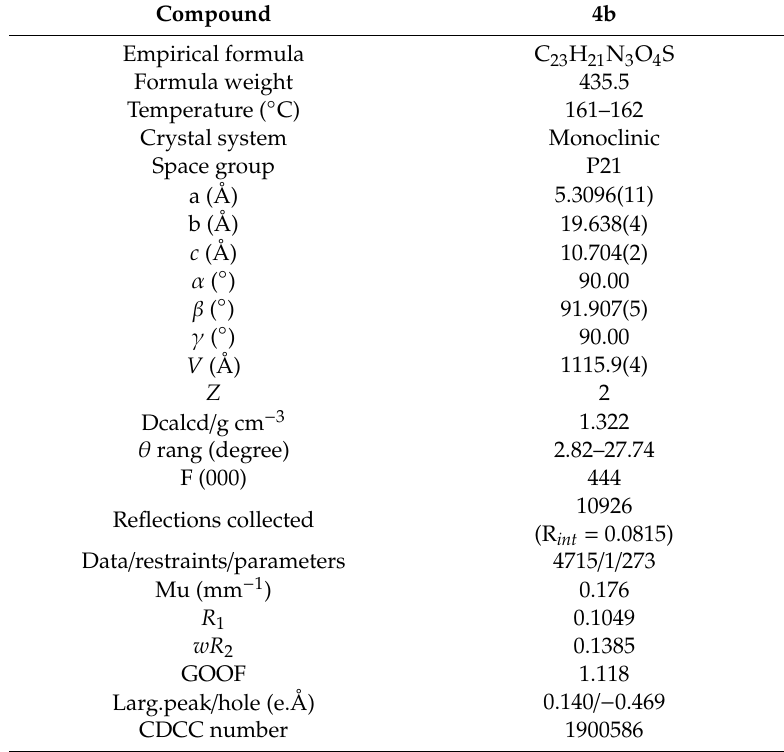
Table 2. Crystal data for compound 4b .